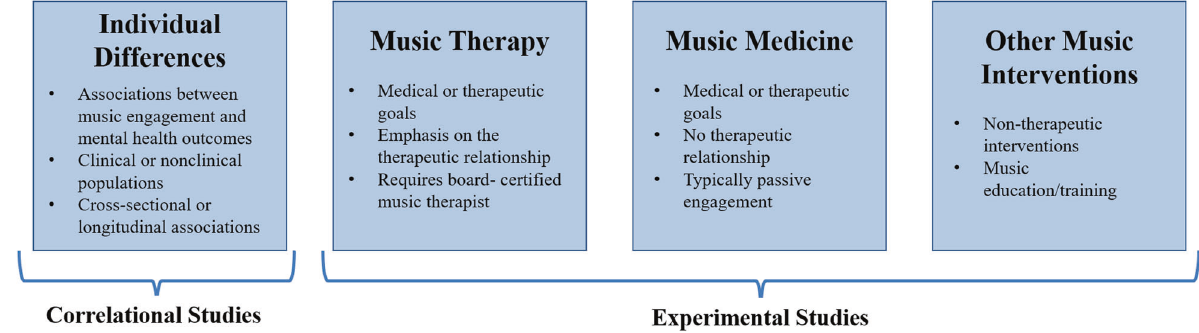
Fig. 1 Example study designs in music-mental health research. Within experimental studies, music interventions can include passive musical activities (e.g., song listening, music and meditation, lyric discussion, creating playlists) or active musical activities (e.g., creative methods, such as songwriting or improvisation and/or re-creative methods, such as song